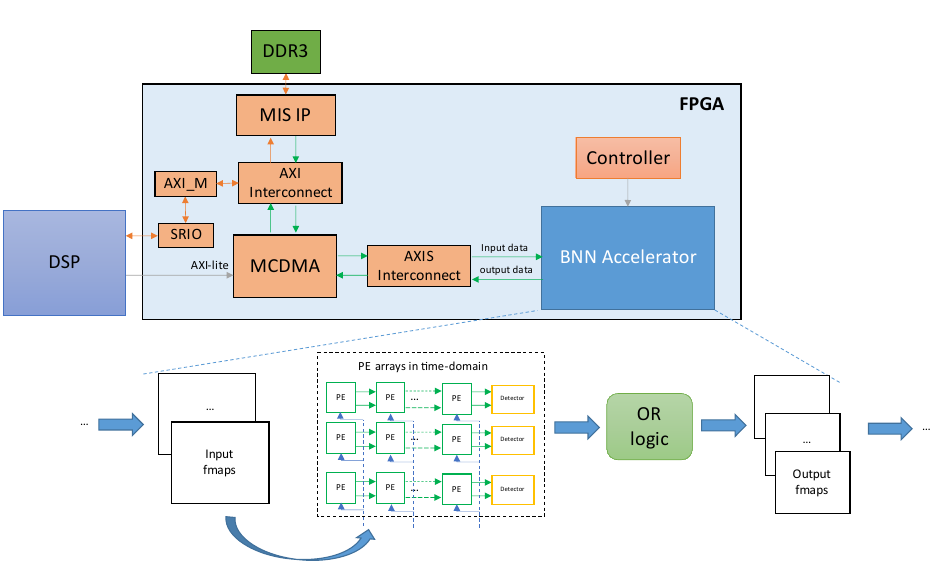
Figure 13. The overall architecture of the BNN accelerator system.